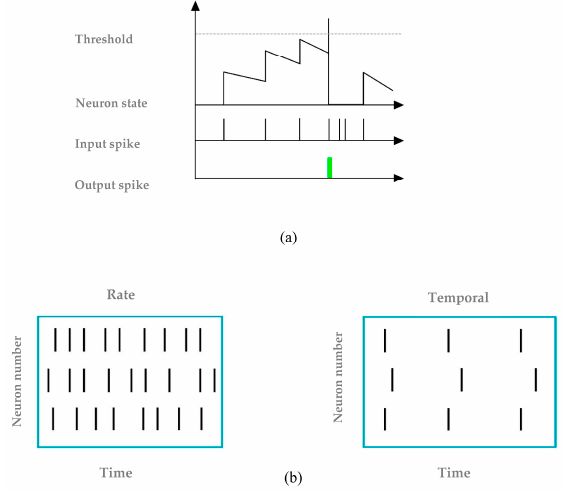
Figure 2. ( a ) An overview of an IF neuron. Whenever the membrane voltage exceeds the firing threshold, an output spike occurs. ( b ) Schematic representation of rate and temporal coding. In a temporal-based encoding, information is encoded through speci fi c spike times, whereas the rate encoding is based on a spiking feature during a time interval.